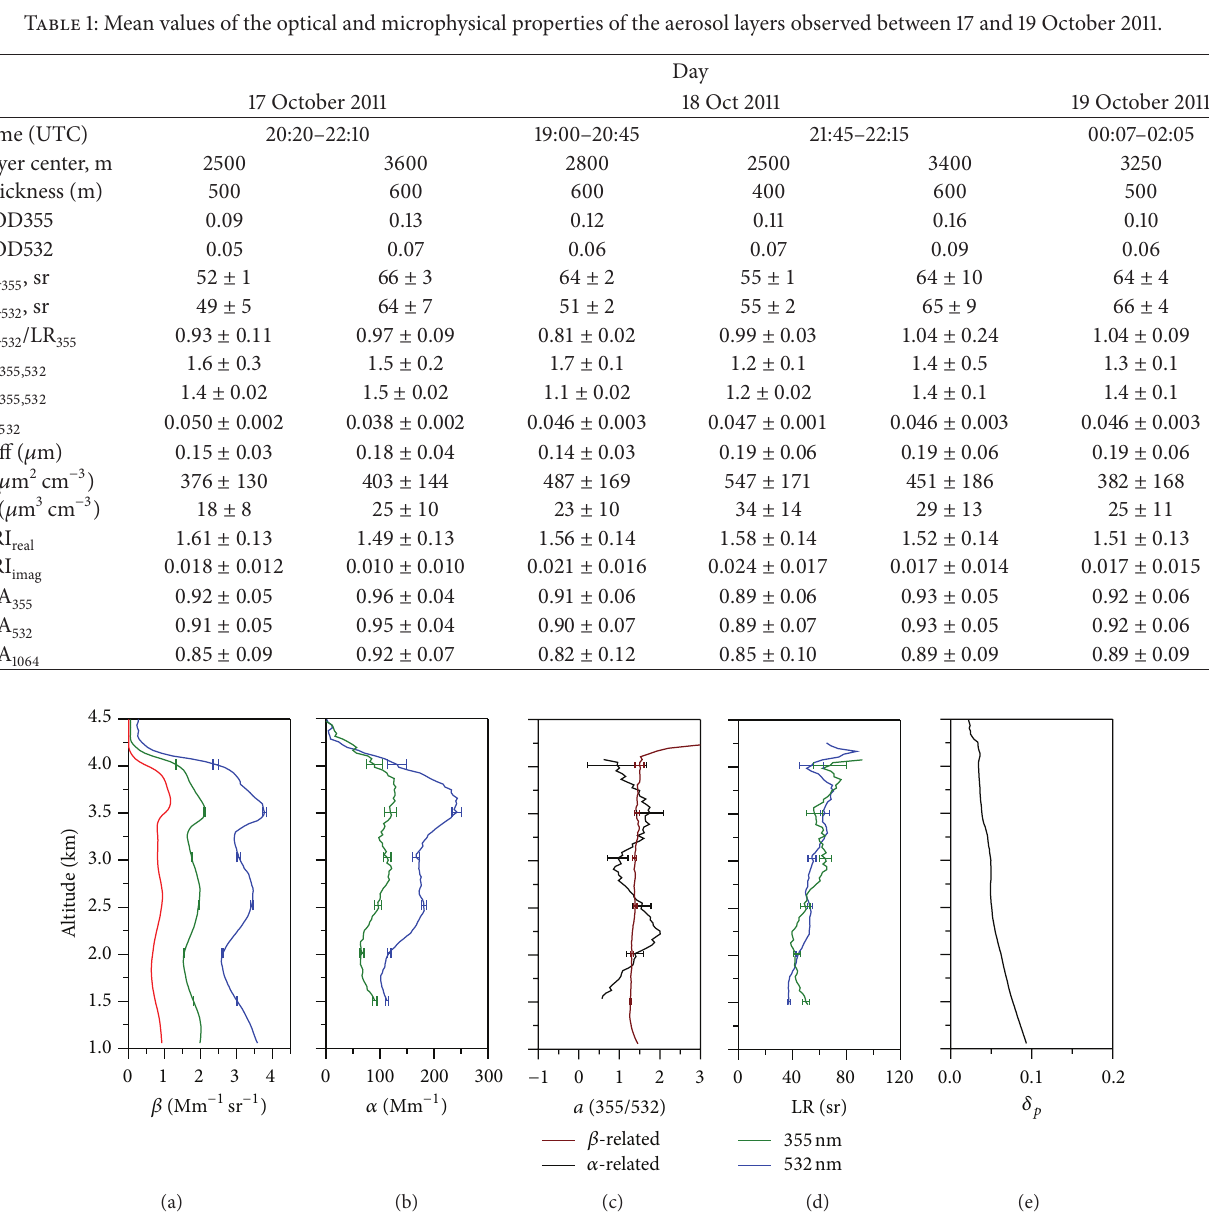
Figure 3: Profiles of (a) backscatter coefficients (355-blue, 532-green, and 1064 nm-red), (b) extinction coefficients (355-blue and 532 nm- green), (c) backscatter and extinction-related ˚Angstr¨om exponent (wavelength pair 355/532 nm), (d) lidar ratios (355 and 532 nm), and (e) particle linear depolarization ratio (532 nm) measured on (a) 17 October 2010 20:20–22:10